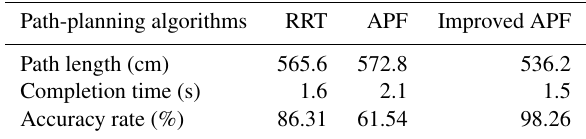
field of the obstacles and the objective point in the motion space is displayed in Fig. 11.